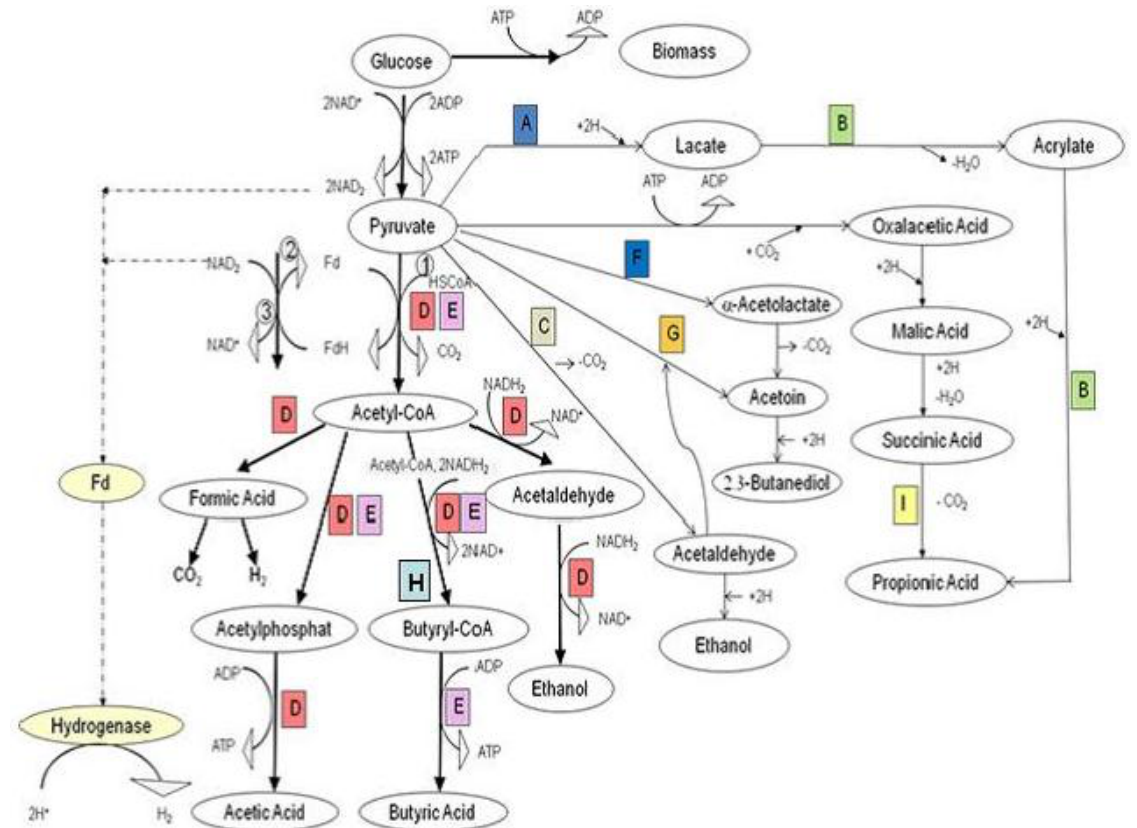
Figure 12. Metabolic pathway of glucose by HPB under anaerobic conditions. ① Pyruvate: ferrodoxin oxidoreductase (PFOR); ② Hydrogenase; ③ NADH: ferrodoxin oxidoreductase. Letters indicate organisms which conduct these reactions as follows: A, Lactic acid bacteria (Streptococcus, Lactobacillus) ; B, clostridium propionicum ; C, Yeast, Acetobacter , Zymomonas , Sarcina ventriculi , Erwinia amylovora ; D, Enterobacteriaceae (coli-aerogens); E, Clostridia ; F, Aerobacter ; G, Yeast; H, Clostridia (butyric, butylic organisms); I, Propionic acid bacteria